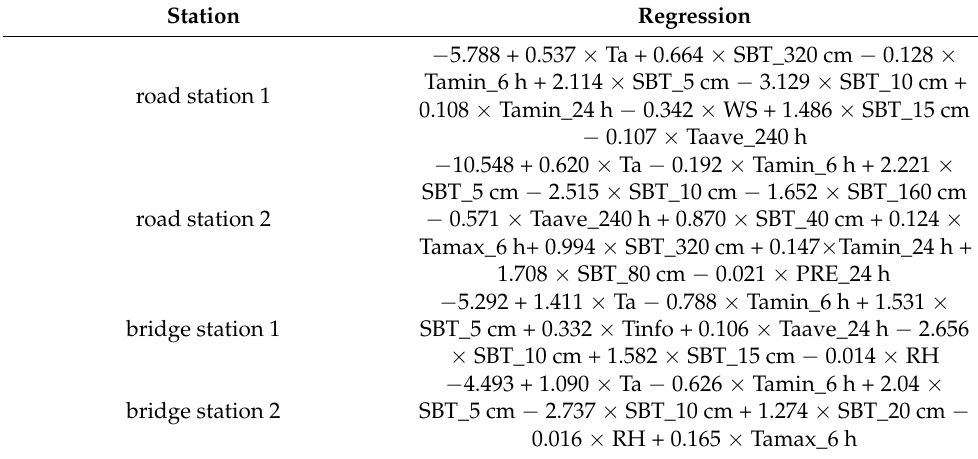
Table 2. Stepwise regression models for each